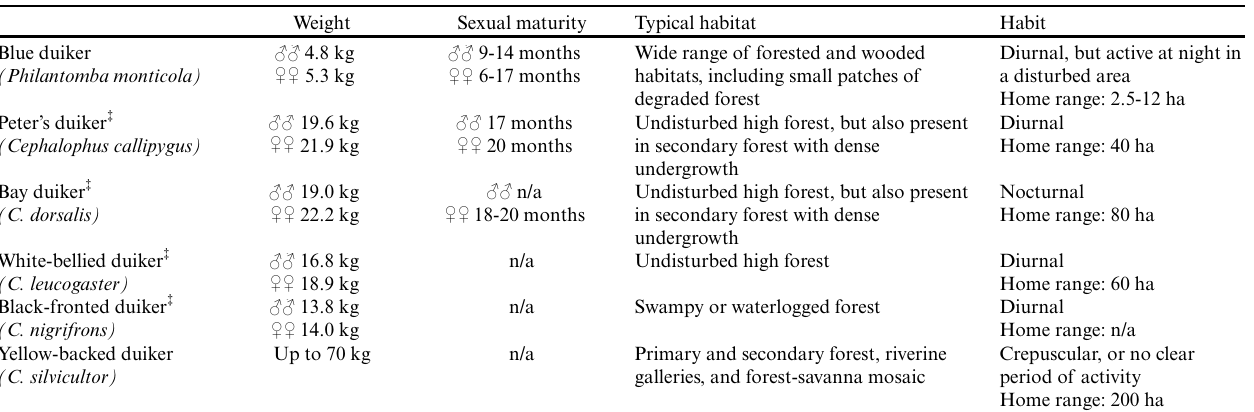
Table 1 . Characteristics of duikers in southeastern Cameroon.